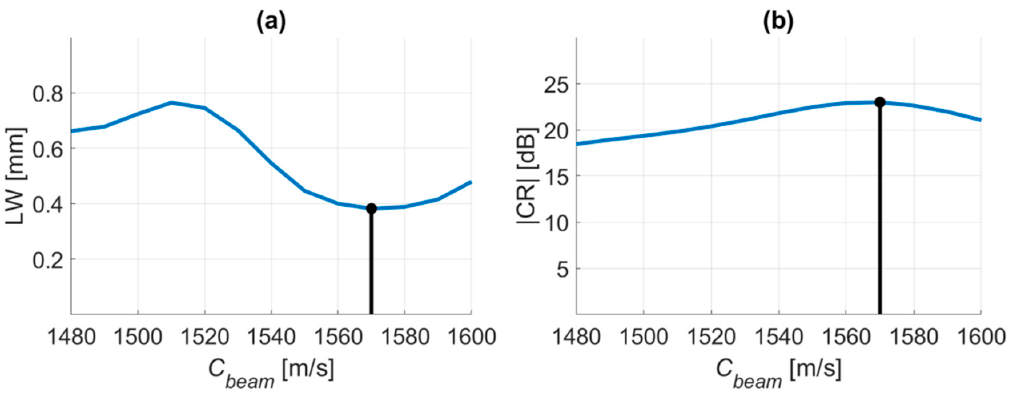
Figure 7. Plot of − 6-dB LW ( a ) and CR ( b ) as a function of C beam for the PICMUS dataset.